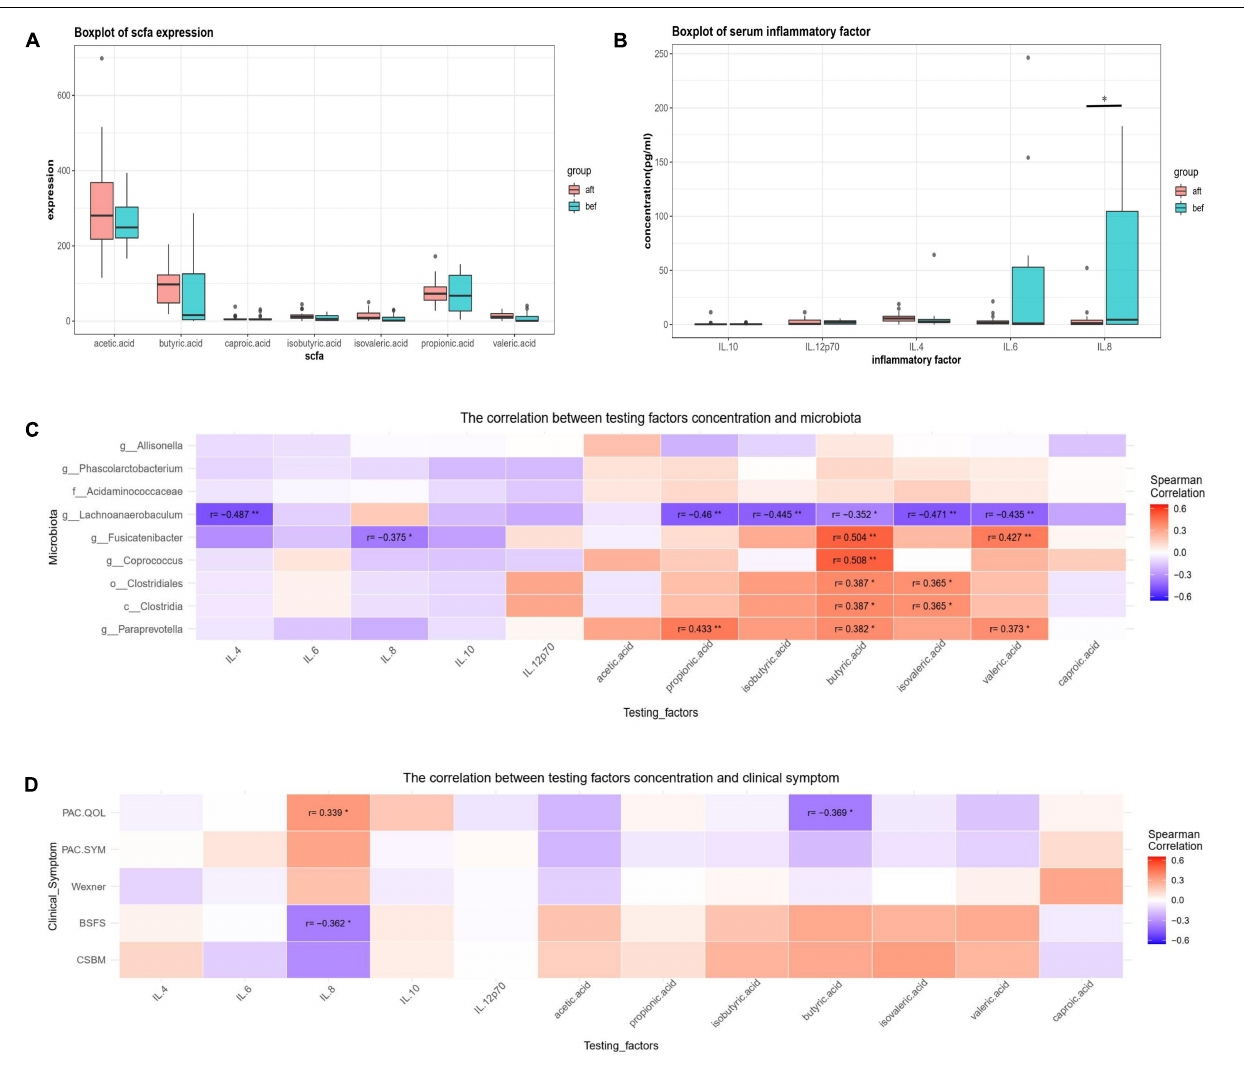
FIGURE 7 | (A) Post-FMT and pre-FMT fecal SCFA concentrations of 18 patients were compared using paired-samples Wilcoxon tests. Butyric acid concentrations increased after FMT but not significantly. (B) Post-FMT and pre-FMT serum inflammatory factors of 18 patients were compared using paired-samples Wilcoxon tests. IL-8 levels decreased significantly after FMT. (C,D) Spearman correlation analysis of pre-FMT and post-FMT clinical symptoms, fecal microbiotas, SCFAs, and serum inflammatory factors of 18 patients revealed that IL-4, IL-8, and some SCFAs (especially butyric acid) were significantly correlated with some bacterial changes. Only IL-8 and butyric acid were correlated with clinical symptoms (“*” represents 0.01 ≤ p < 0.05; “**” represents 0.001 ≤ p <